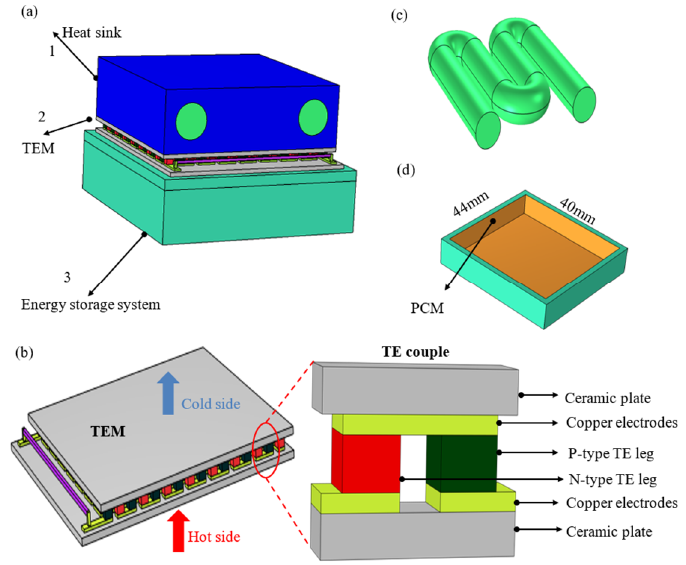
Figure 2. Diagram of the TEG system. ( a ) TEG system with phase change material. ( b ). Structure of thermoelectric module. ( c ) Snake tube. ( d ) Energy storage system.